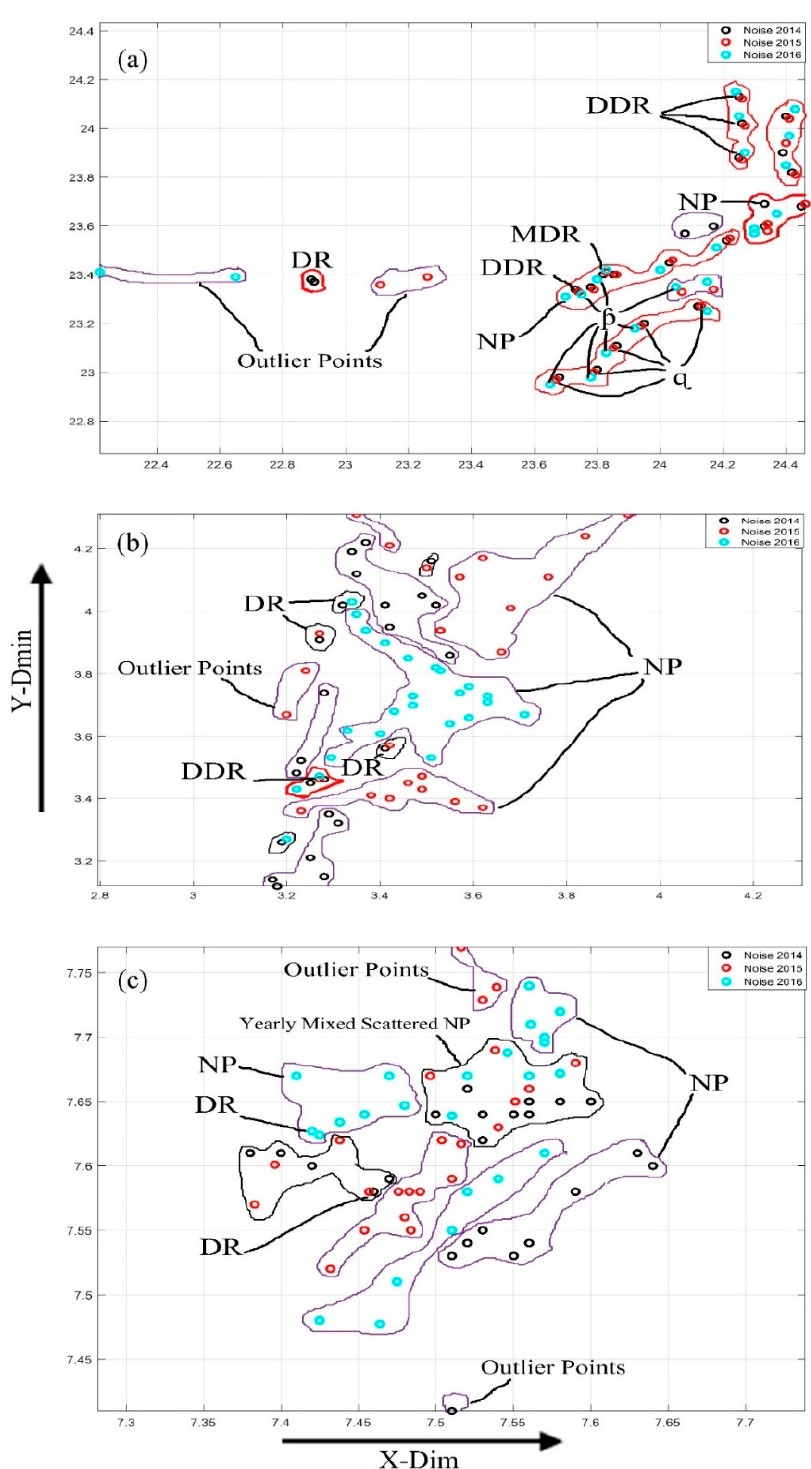
Figure 8. Density-based spatial clustering of applications with noise (DBSCAN) analysis of seasonal variation in stream parameters. eps is in cm, and MinPts is the number of points in the group N_noise. ( a ) Temperature DBSCAN clustering where eps = 1.9073 × 10 − 6 and MinPts = 3; ( b ) DO DBSCAN clustering where eps = 2.3842 × 10 − 7 and MinPts = 12; and ( c ) pH DBSCAN clustering where eps = − 50 and MinPts = 0.01. DR: Density Reachability; DDR: Directly Density Reachability; MDR: Maximum Density Reachability; NP: NOISE/Noise Points; ɋ ; Core Points; ƥ: Border Points .